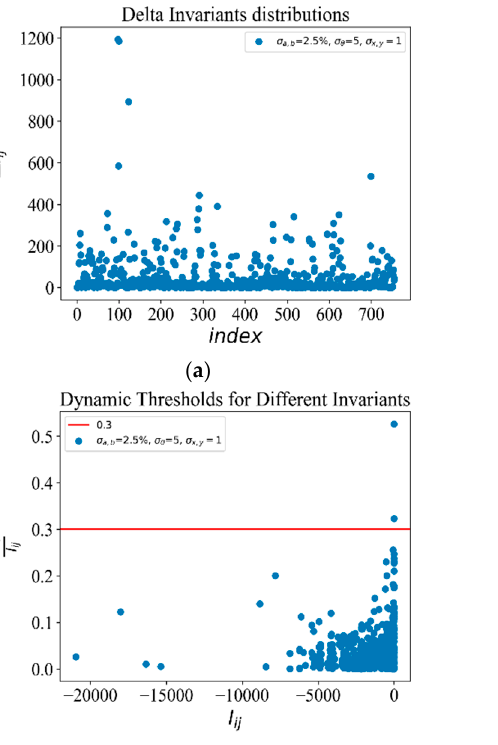
Figure 4. Detection errors for overlapping craters: ( a ) when elliptical craters overlap, it is generally easier to detect only large craters; ( b ) When elliptical craters are close enough, it is generally easy to be mistakenly detected as red ellipse; ( c ) When elliptical craters are partial overlap, it is gener- ally easy to be mistakenly detected as red ellipse;